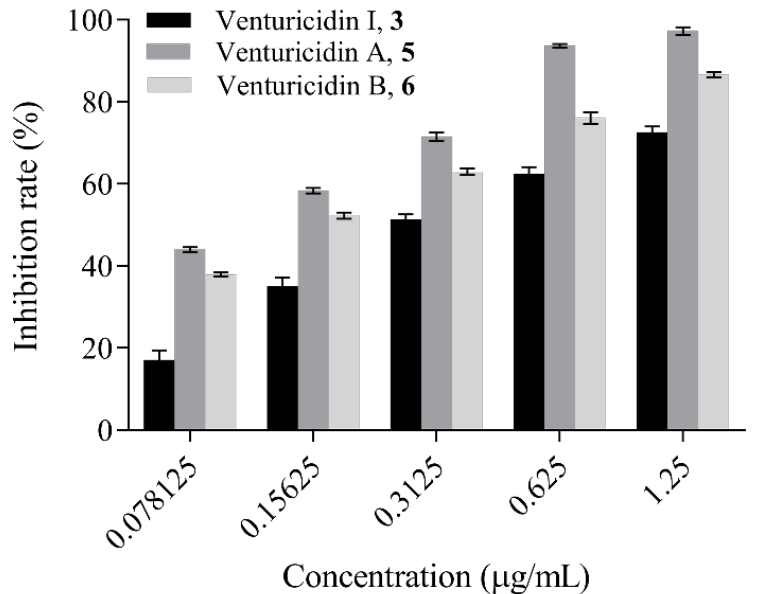
Figure 3. Effect of venturicidin I, 3 , venturicidin A, 5 , and venturicidin B, 6 on mycelial growth of P. oryzae.